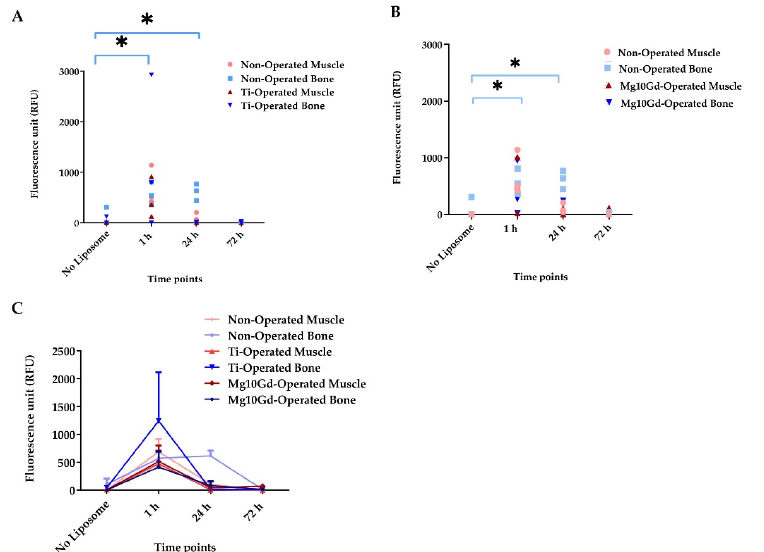
Figure 7. The fluorescence was measured in all three groups using FMT for observing the clearance and signal retention. ( A ) Fluorescence intensities were compared between the non-operated group and the operated group with Ti screw. Data from each animal are presented. ( B ) Fluorescence intensity changes were compared between the non-operated and operated groups with Mg-10Gd screw. Individual animals are presented. ( C ) Fluorescence intensities with the average signal from each group. Data are expressed as the mean ± standard error of the three samples per group; * p < 0.05 .